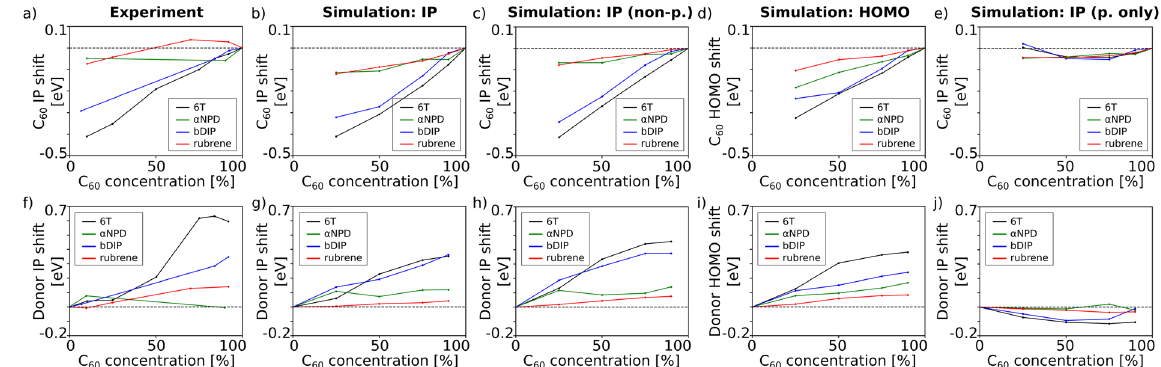
Figure 2. Shift of the IP of C 60 ( a–e ) and donor materials ( f–j ) as a function of the C 60 content. Experimental data by Graham et al . is shown in ( a,f ). Calculated IP shifts are shown in ( b,g ). Panels (c,h) show IP shifts without the influence of polarization effects and panels (d,i) show calculated HOMO energy shifts instead of IP shifts. Panels (e,j) show the energy level shifts as a function of pure polaronic polarization (dynamic polarization), which we calculated as the difference of panels (b/c) and (g/h),